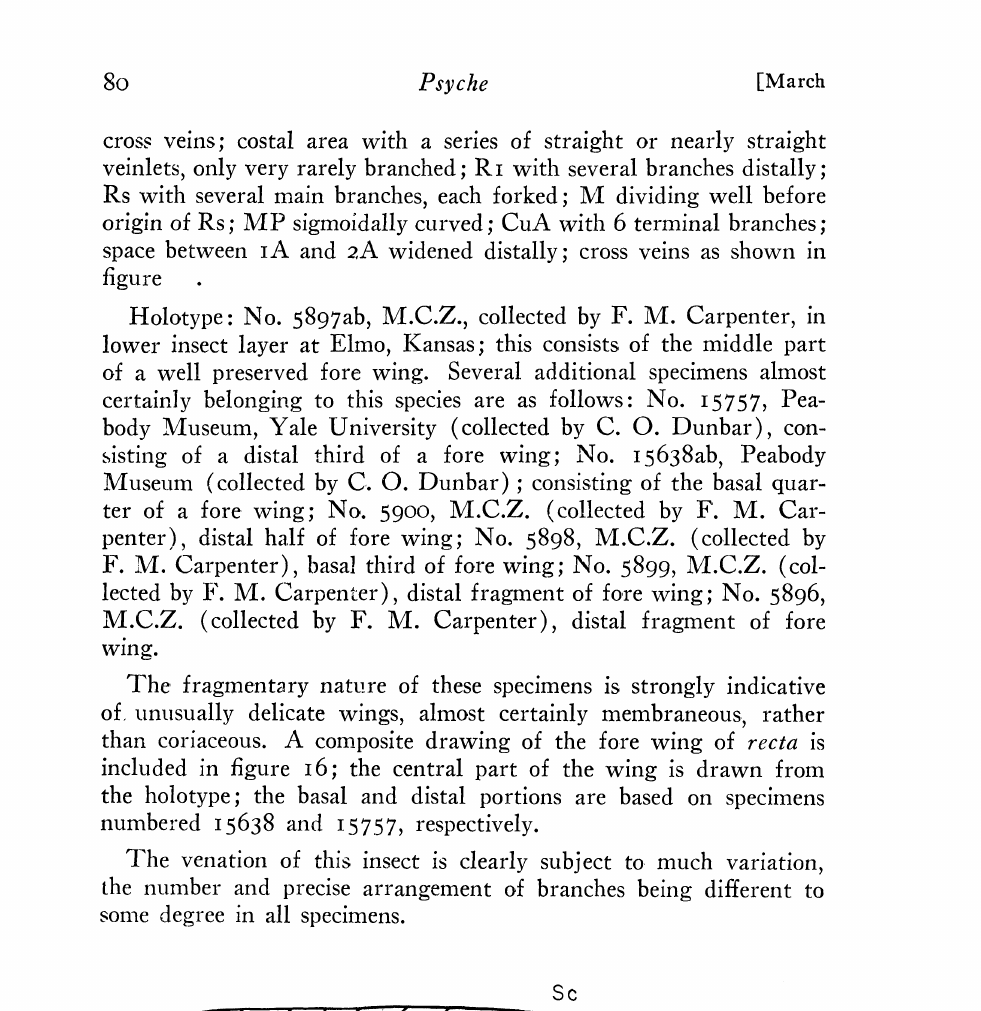
Text-figure 17. Paroedischia maculata, n. sp. Drawing of fore wing